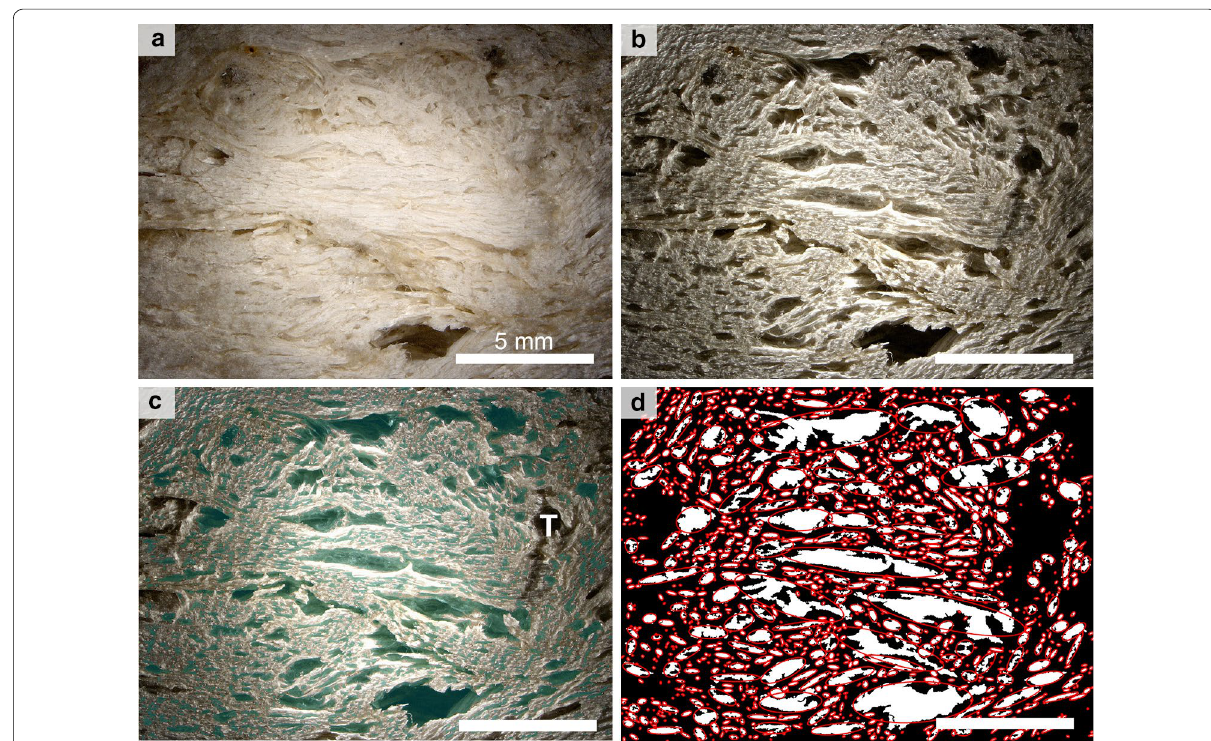
Fig. 3 Digital stereo microscope images. Images a with the conventional light (Fig. 2a) and b with the adjustable low-angled ring illumination (Fig. 2b). c A green/transparent binary image overlying the image of b . The green-colored parts are bubbles recognized by image processing. ‘T’ indicates trace holes of crystals. d A white/black binary image of the recognized bubbles. Ellipses fitting the bubbles are shown in red. The white bar shows a 5-mm scale in all